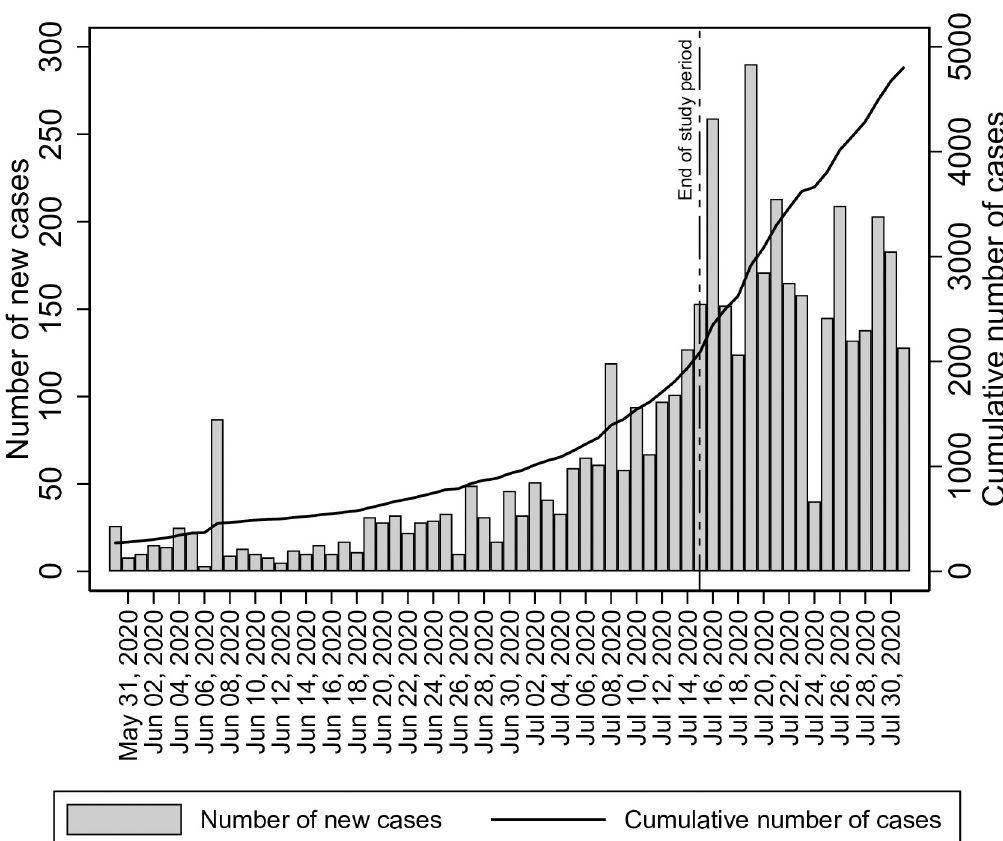
Fig 2. Daily new cases of SARS-CoV-2 and the cumulative number of cases in District Srinagar, June-July 2020.